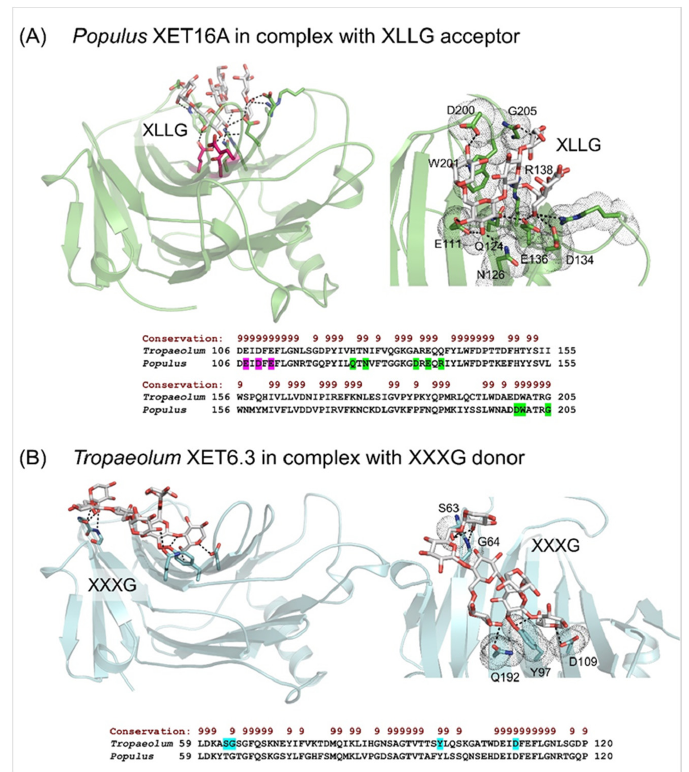
Figure 2. β -Sandwich architectures and β -jelly-roll topologies of Populus XET16A (PDB accession 1UMZ) in complex with the XLLG acceptor substrate ( A ), and the Tropaeolum XET6.3 3D molecular model in complex with the XXXG donor substrate ( B ). ( A ) Left panel : The XLLG acceptor (cpk sticks) bound in the Populus XET16A structure is indicated in dashed lines at 2.6 Å to 3.5 Å separations. The catalytic trio (Glu85, Glu89 and Asp87) is shown in cpk magenta sticks. Right panel : Details of the XLLG binding in Populus XET16A; interacting residues are marked in green cpk sticks and dots. Bottom panel : Some of the residues of Populues XET16A binding XLLG (highlighted in green) are shown in the alignment by PROMALS3D [83] of the Populus and Tropaeolum XET sequences (numbering includes signal peptides). Conservation of residues on the scale 9–6 is shown on the top of the alignment in brown. ( B ) Left panel : The XXXG donor (cpk sticks) bound in Tropaeolum XET6.3 (cyan; coordinates from [66]) is indicated in dashed lines at separations between 2.3 Å and 3.0 Å. Right panel : Details of XXXG binding in Tropaeolum XET6.3; interacting residues are marked in cyan cpk sticks in dots. Bottom panel : Some of the residues of Tropaeolum XET6.3 binding XLLG (highlighted in cyan) are shown in the alignment by PROMALS3D [83] of Populus XET16A and Tropaeolum XET6.3 sequences (numbering includes signal peptides). Conservation of residues on the scale 9–6 is shown on the top of the alignment in brown. Images were generated in the PyMOL Molecular Graphics System v2.5.2 (Schr˝odinger LLC, Portland, OR,